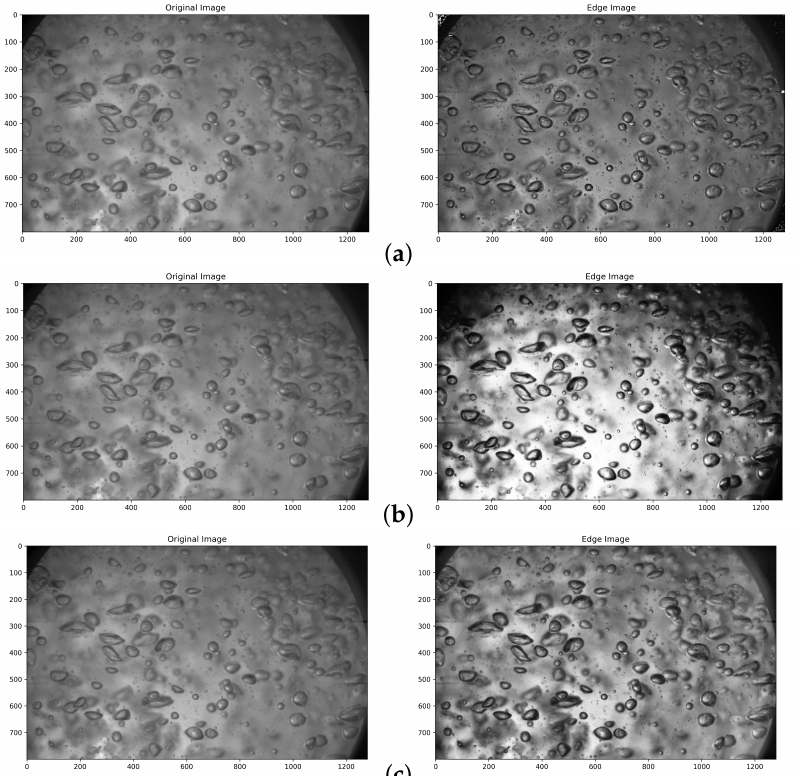
Figure 3. Image transformations after application of ( a ) black-hat transform, ( b ) histogram equal- ization and ( c ) CLAHE on the sample frame from the F3 video. One can see that all the methods highlight edges in different ways. After the series of tests for all the transformations above the black hat transform was selected as the most promising and correct.